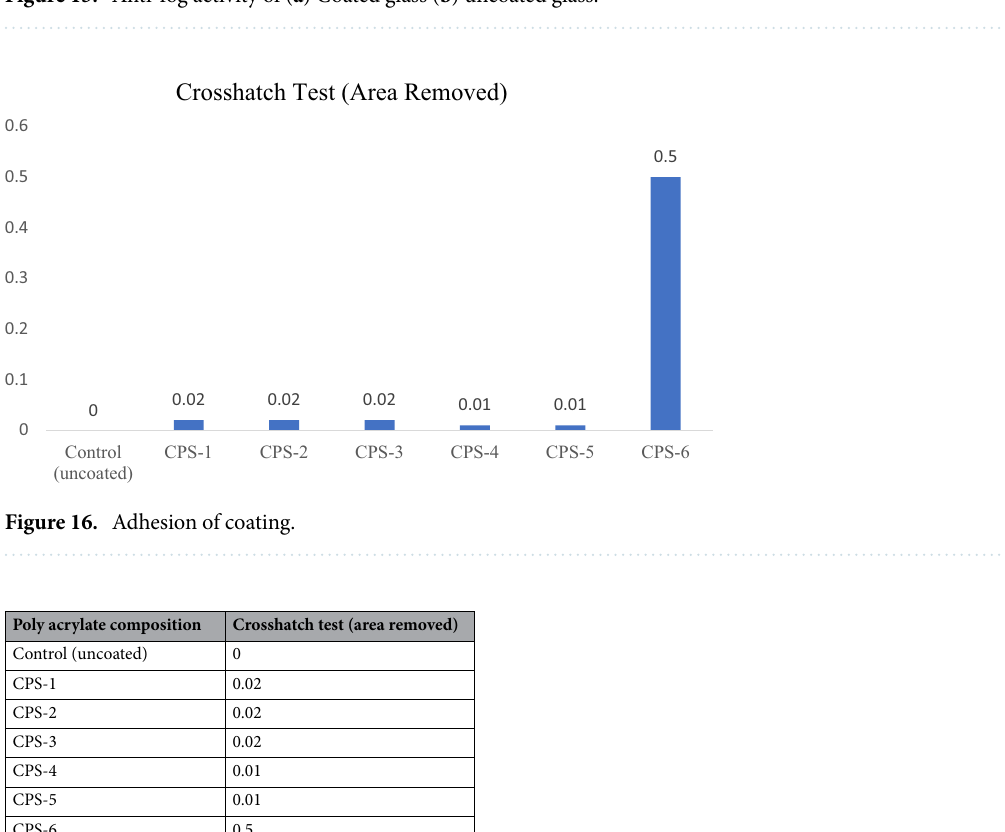
Figure 15. Anti-fog activity of ( a ) Coated glass ( b ) uncoated glass.